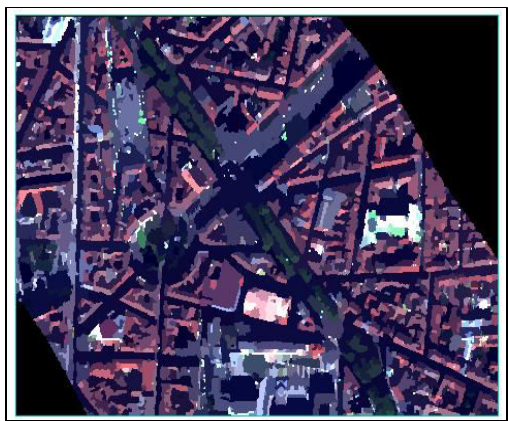
Figure 3. Segmented HySpex